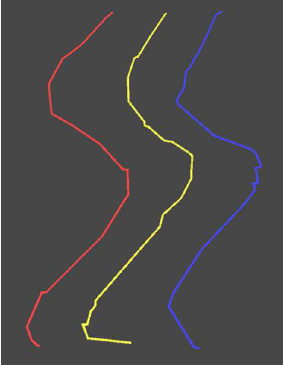
Fig. 15 Recorded paths of user UN12: RP(red), OP(yellow) and SP(blue)